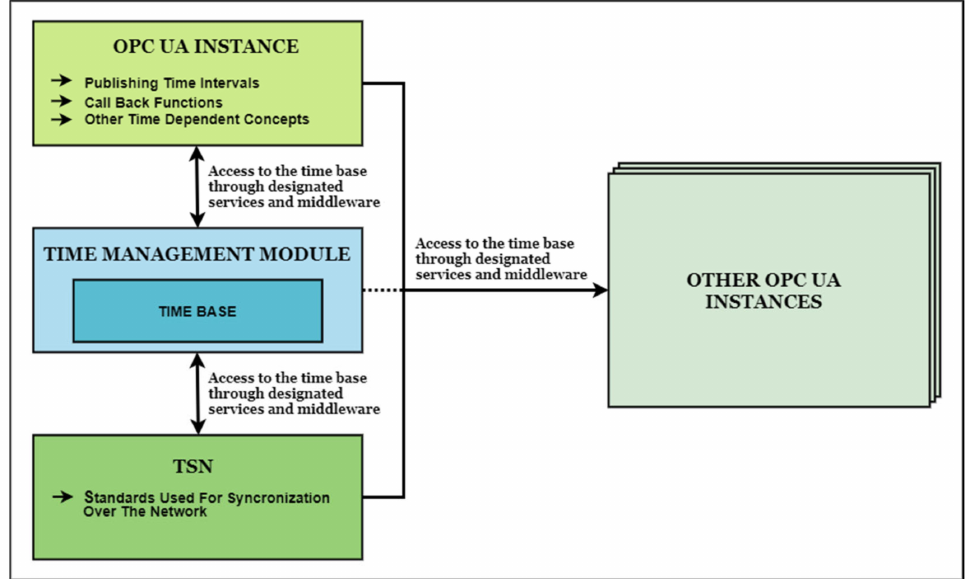
Figure 2. Proposed design with all entities relying to a common time